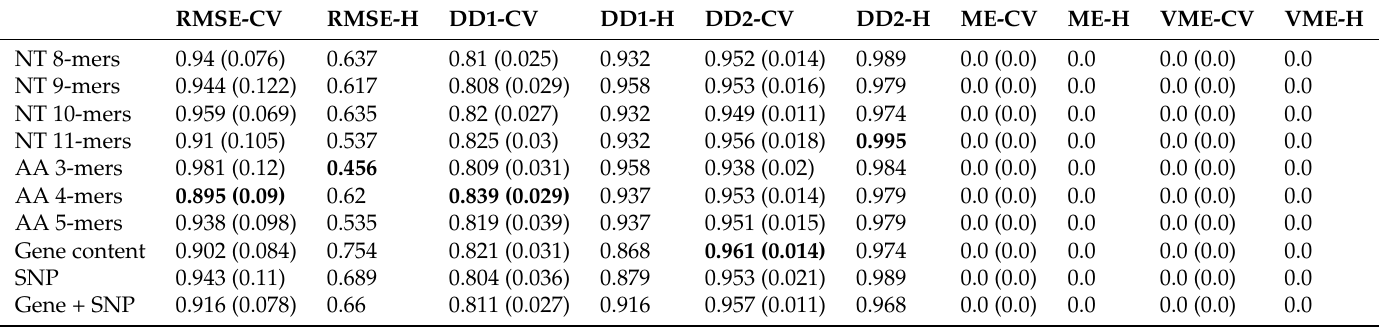
Table A26. N. gonorrhoeae